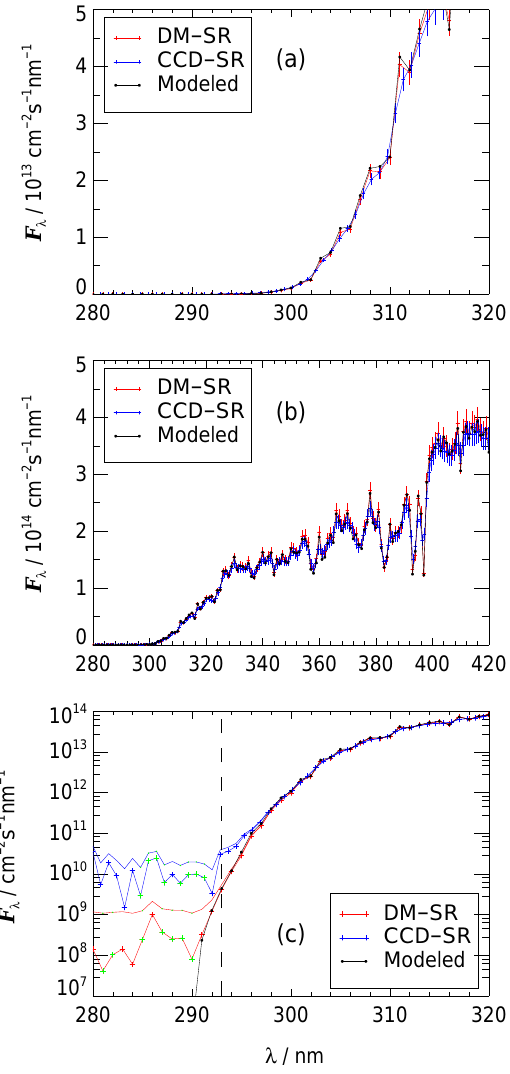
Figure 17. Comparison of actinic flux density spectra obtained on the ground with a double-monochromator-based reference instru- ment (DM-SR; red) and instrument 62001 (blue). Measurements were made on 1 August 2013 at Jülich (Germany) under clear-sky conditions. The spectra were taken around 12:00UTC at a solar zenith angle of 33 ◦ and an ozone column of 310DU. Black data points show the results of radiative transfer calculations for the same conditions. The different representations emphasize the increase of actinic flux densities in the UV-B range in panel (a) and the dynamic range of data in panel (b) . Green data points in the semilogarithmic plots of panel (c) show negative values that were plotted at their ab- solute values to make them visible. Full lines with minimum symbol size indicate the corresponding upper or lower limits after addition or subtraction of instrument noise. The dashed vertical line shows the cutoff wavelength below which values of the CCD-SR were nor- mally set to zero. Note the different spectral actinic flux density and wavelength